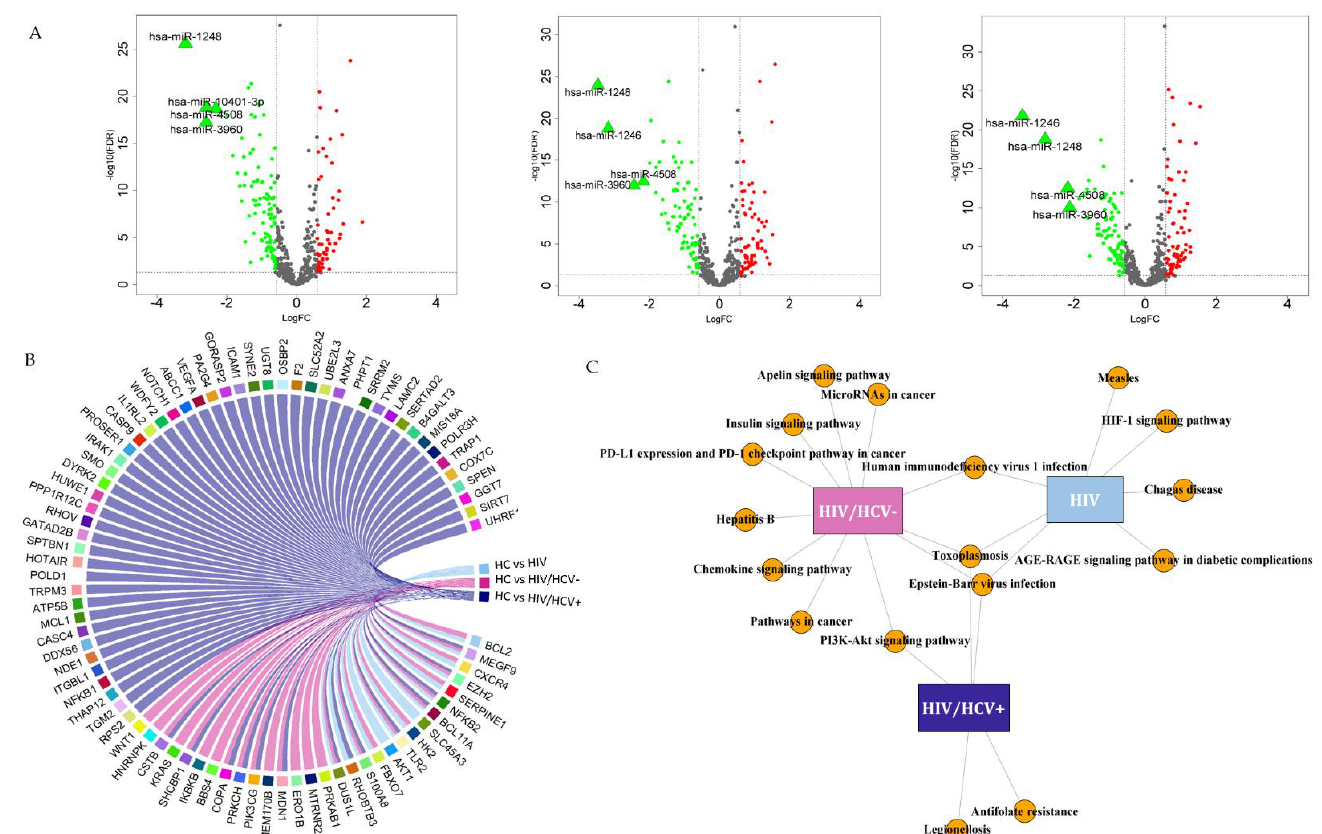
Figure 2. Analysis of differentially expressed miRNAs in HIV patients relative to healthy controls, potential target genes and molecular routes. ( A ) Volcano plots of SDE miRNAs in PBMCs of HIV/HCV+ ( left ), HIV/HCV- ( middle ) and HIV ( right ) patients compared to healthy controls. The expression level change (log 2 FC) and significance ( − log 10 FDR) have been positioned on the x -axis and y -axis, respectively. The colored dots represent significantly differentially expressed miRNAs, indicating upregulation in green and downregulation in red. Those SDE miRNAs with strong up/downregulation (Log 2 FC > 2 or Log 2 FC < − 2) are highlighted in wider triangle-shapes and labelled. ( B ) Chord diagram showing the enriched target genes for the SDE miRNAs in the HIV-infected groups (HIV/HCV+ in purple, HIV/HCV- in pink and HIV in blue). ( C ) Network map associating the enriched gene targets and their most significant biological process (KEGG pathways).